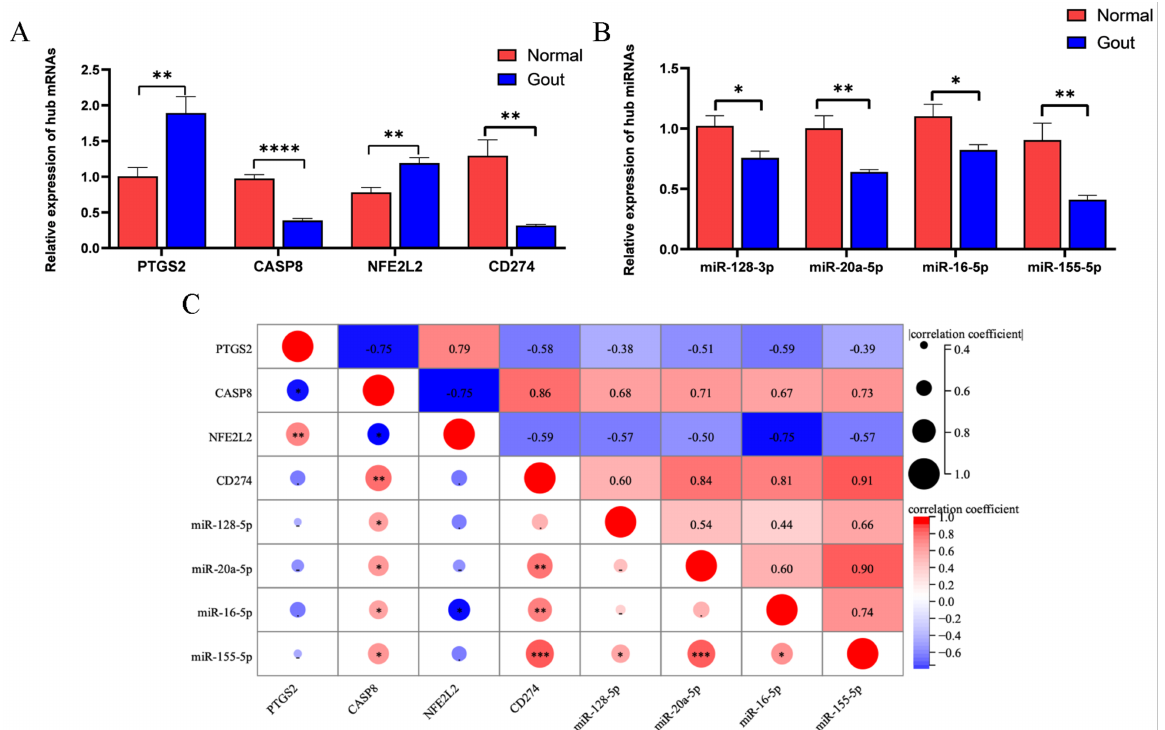
Figure 3. Verification of key differentially expressed genes related to gout and pyroptosis: ( A ) Expression of mRNAs; ( B ) Expression of miRNAs; ( C ) Pearson correlation analysis of mRNAs and miRNAs. (* p < 0.05; ** p < 0.01; *** p < 0.001; **** p < 0.0001).